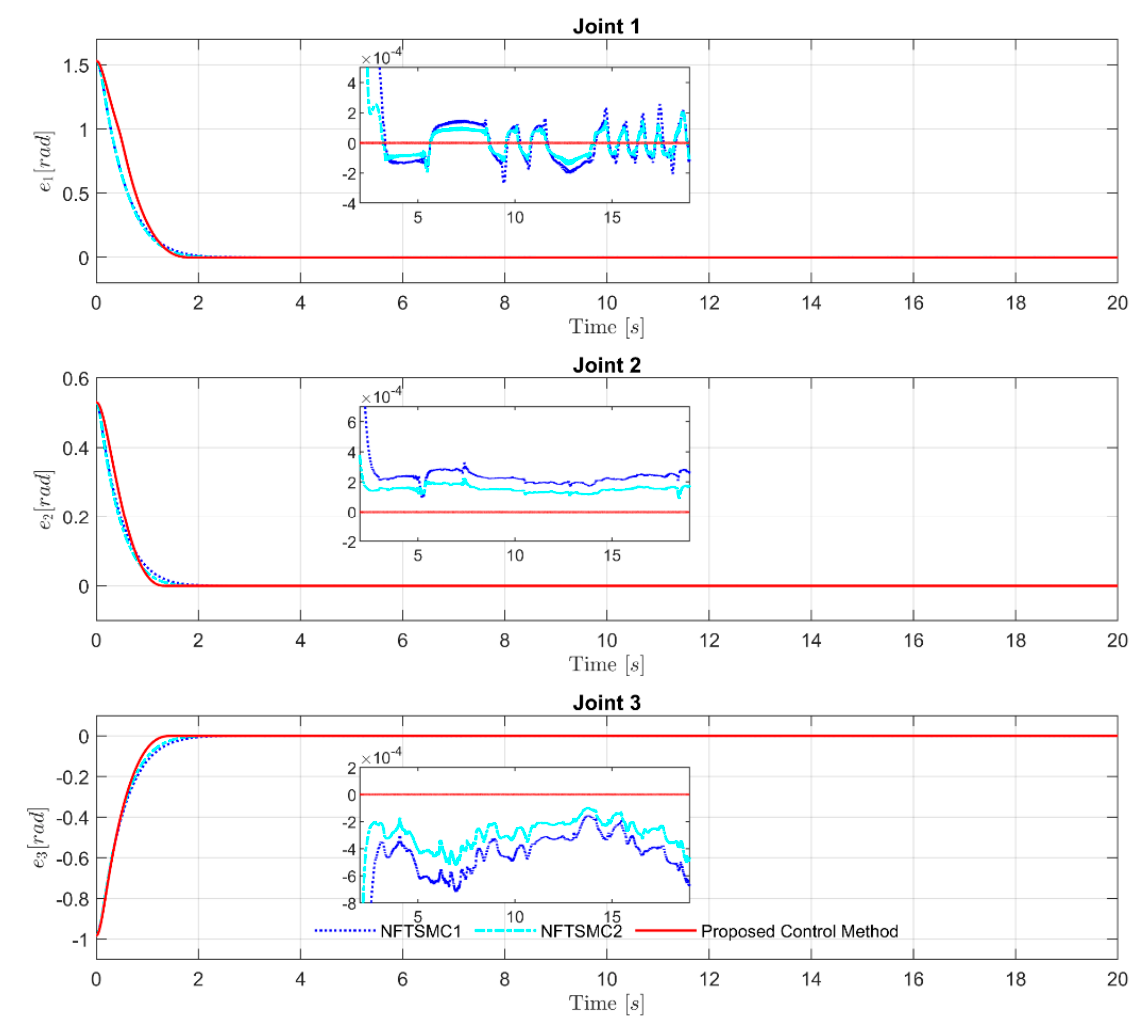
Figure 7. Path of the control errors at each joint.